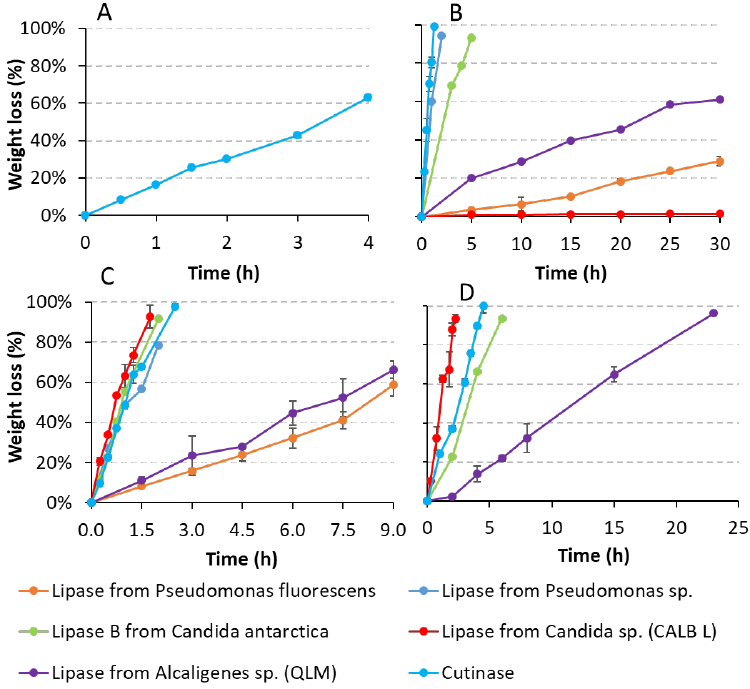
Figure 3. Weight loss (%) of PBS ( A ), PBSA ( B ), PCL6500D ( C ) and PCL6800D ( D ) films over time (hours) in the presence of the different enzymes. Table 4. Enzymatic degradation rate (mg/h/cm 2 ) of PBS, PBSA, PCL6500D and PCL6800D in the presence of the different